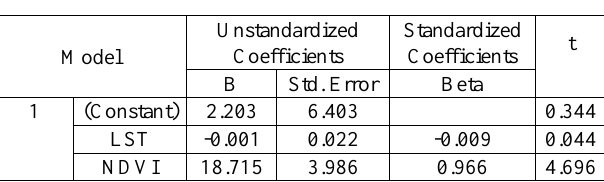
Table 4. Regression coefficients and statistical criteria of soil moisture estimation model.